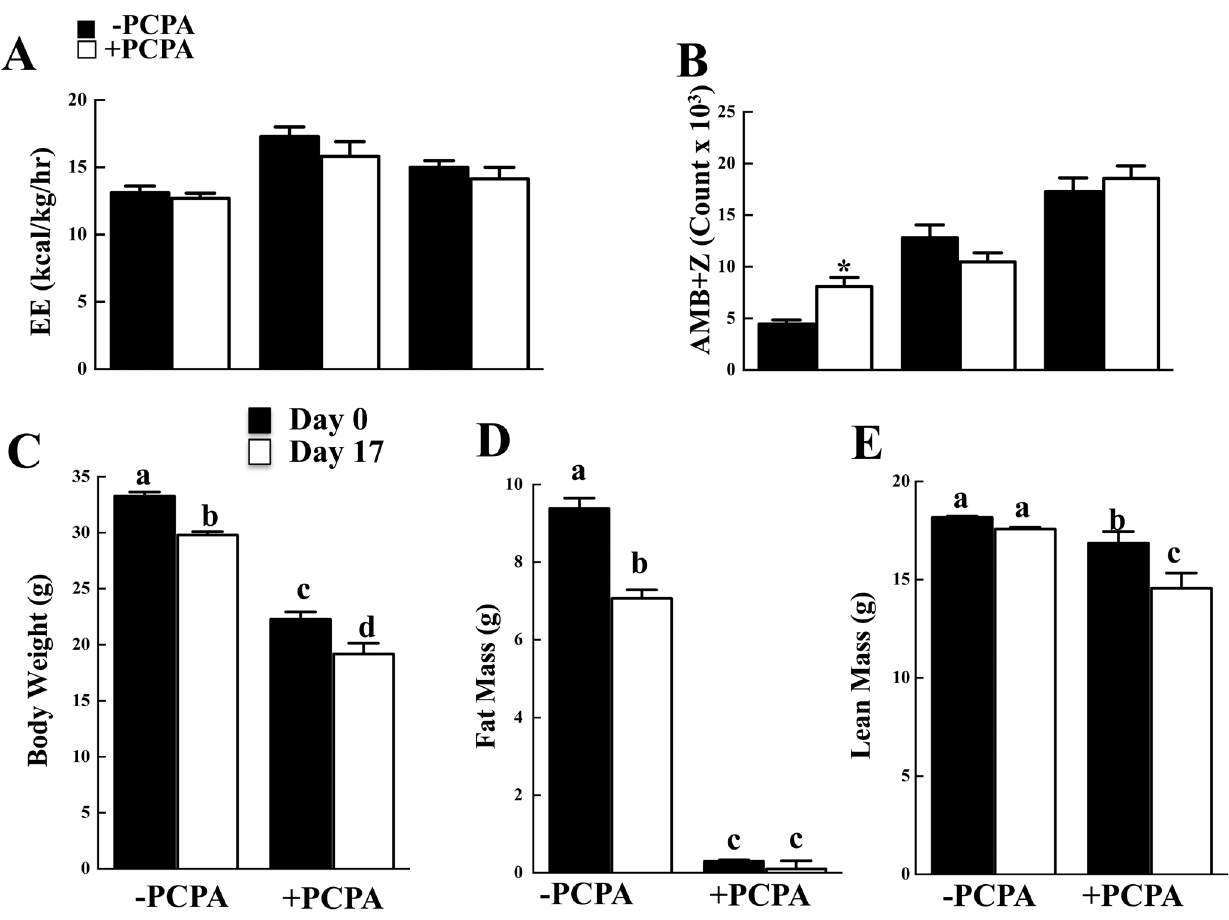
Figure 4. Mice treated with 2-PCPA for 90 days do not exhibit increased energy expenditure. Indirect calorimetry was carried out on mice fed a HFD with or without 2-PCPA for 90 days. (A) Energy expenditure. (B) Sum of ambulatory and vertical movements. (C) Daily food intake as measured every other day throughout the experiment. n=5 in each group. The bars represent means 6 standard errors. (*) indicates a statistically significant difference (p , 0.05) between the 2-PCPA treated and non-treated groups. Mice were fed a HFD with or without 2-PCPA for 21 days and fed ad libitium. The mice were then restricted to 70% of their individual food intake for 17 days. (C) Body weight. (D) Fat mass. (E) Lean mass. n=5 in each group. In panels (A) and (B) the bars represent means 6 standard errors. (*) indicates a statistically significant difference (p , 0.05) between the start (day 0) and end (day 17) of caloric restriction. In panels (C) and (D) statistical analysis was performed using a two-way ANOVA followed by the Student-Newman-Keuls multiple range test. Identical letters indicate data points that are not statistically different from each other (p ,